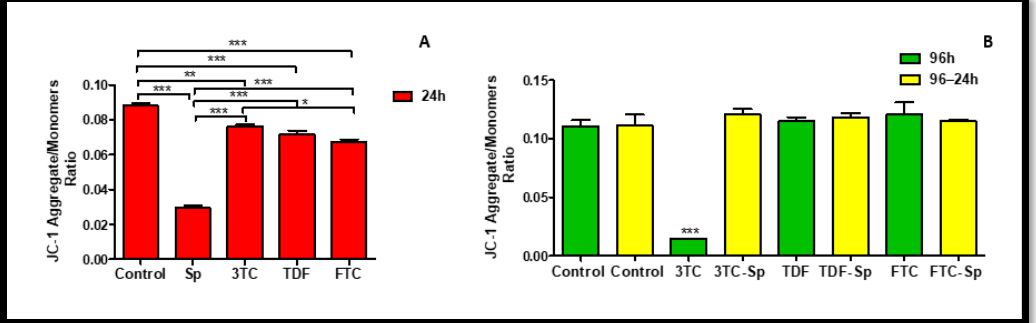
Figure 8. Mitochondrial response. ∆ m ψ represented as a ratio of JC-1 aggregates and JC-1 monomers. The ∆ m ψ after exposure of HepG2 cells to ( A ): SP and HAART for 24 h, ( B ): HAART (96 h), and HAART (96 h) followed by SP (24 h); * p < 0.05, ** p < 0.005, *** p < 0.0001.